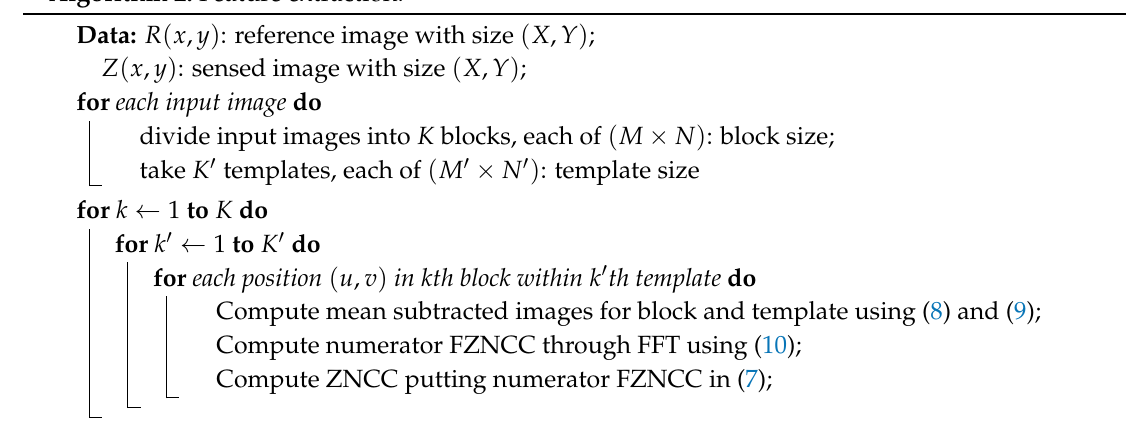
Algorithm 2: Feature